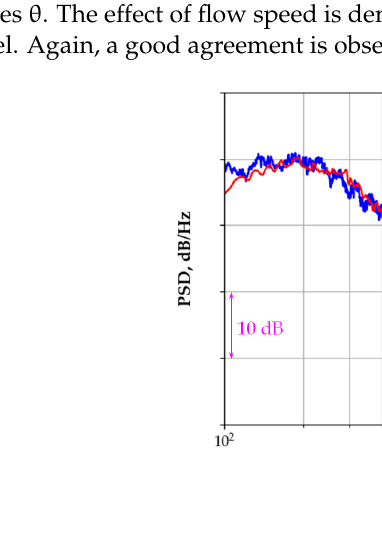
( b ) Figure 15. Comparison of the normalized spectra of the four-wheel landing gear model with the high main leg. Microphone is at ( θ , φ ) = (90°, 20°). Flow speed is ( a ) 34 m s − 1 , ( b ) 55 m s − 1 . Finally, Figure 16 illustrates the effect of landing gear model geometry, providing results for the six-wheel model with high and medium main legs. The spectra collapse very well, with the possible exception of a hump, which is present in the FL-17 CARDC spectra at the frequency ~1250 Hz. Localization of the noise sources for the frequency is shown in Figure 17 and demonstrates that the hump is likely to be related to the support structure between the wheels, so that the noise generation mechanism can be similar to that considered in [22] for two-wheel landing gear models. Investigation of wheels of different diameters in [22] leads to a conclusion that the tonal noise can be generated by a laminar flow around the support structure between the wheels and is more likely to ap- pear for wheels with smaller diameters, which is exactly the case for the six-wheel land- ing gear model (Figure 8a).